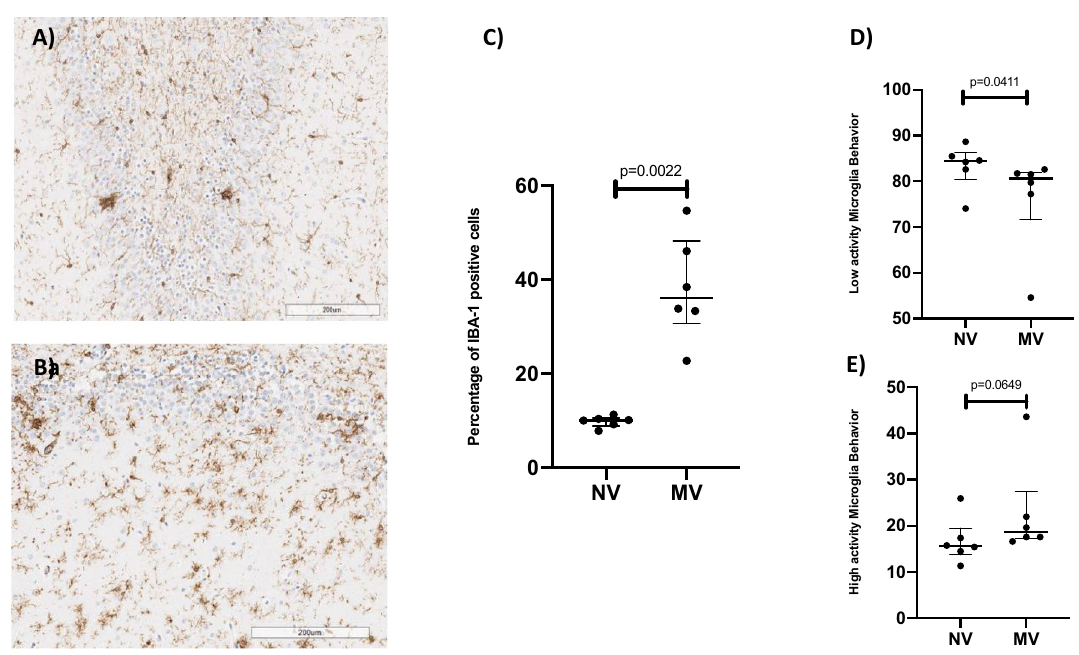
Figure 4. Slide of an NV subject’s hippocampus ( A ) and an MV subject’s hippocampus ( B ) after staining by IBA-1, showing normal cells (blue) and IBA-1-positive cells (brown). ( C ) Dot plot showing percentages of IBA-1-positive cells, combining the two behaviors of microglia, 10.12 (8.93–10.65) in the NV group and 36.17 (30.71–48.27) in the MV group, p = 0.0022 (n = 6 per group). ( D ) Dot plot showing percentages of low- activity microglia behavior, 84.40 (80.49–86.27) in the NV group and 80.63 (71.59–81.93) in the MV group, p = 0.0411 (n = 6 per group). ( E ) Dot plot showing percentages of high-activity microglia behavior,